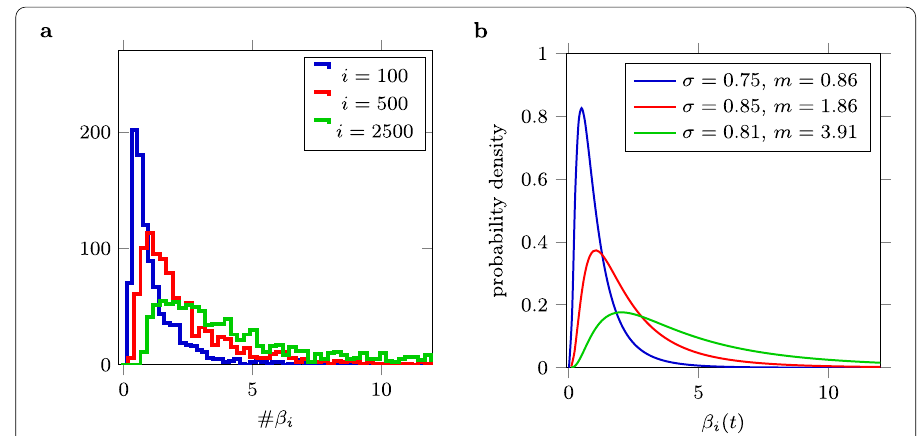
Fig. 17 a Empirical histograms for values of β i ( n ) , i = 100,500,2500 , obtained by simulating of 1000 TC networks of size 5000; b the density functions of log-normal distribution with parameters estimated for the corresponding samples of β i ( n ) , i = 100,500,2500 , obtained by simulating of 1000 TC networks of size